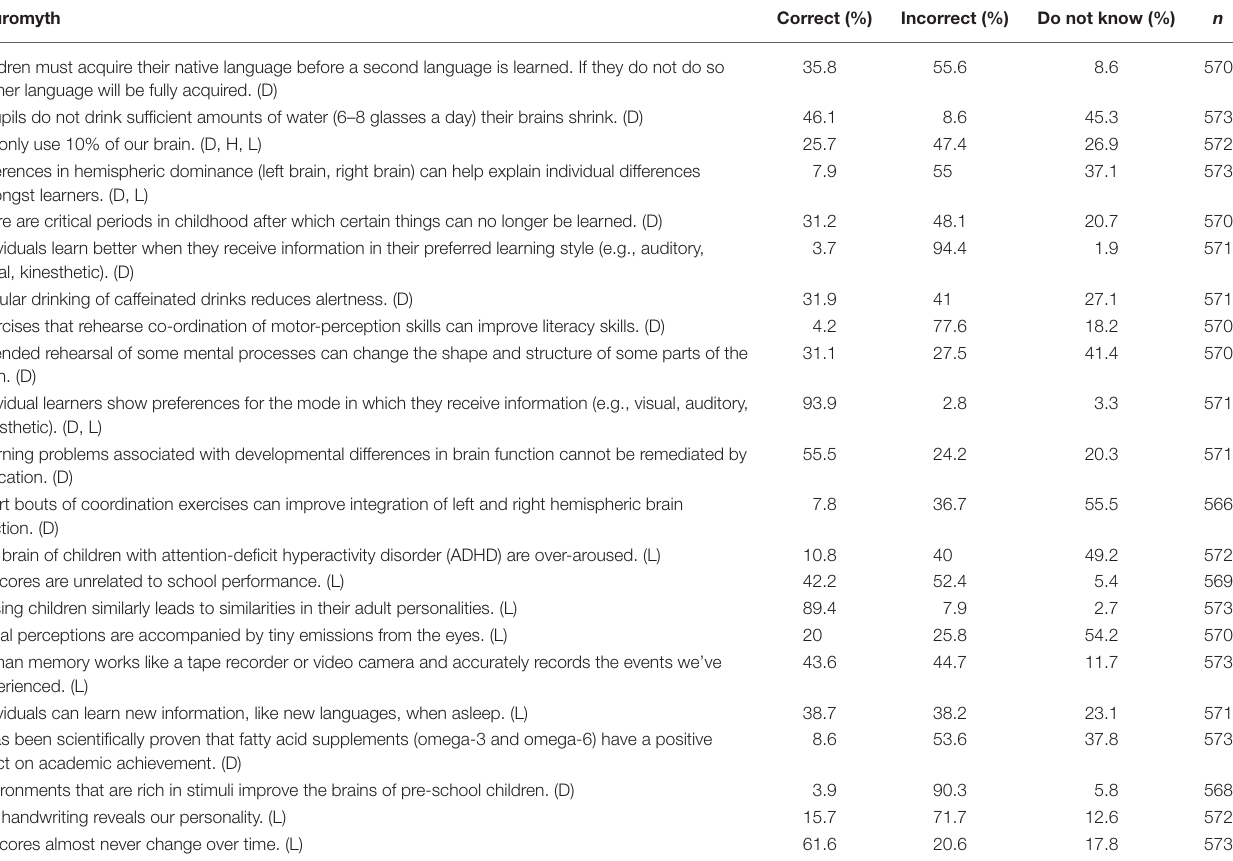
TABLE 1 | Correctness of responses for all myth assertions. Neuromyth Correct (%) Incorrect